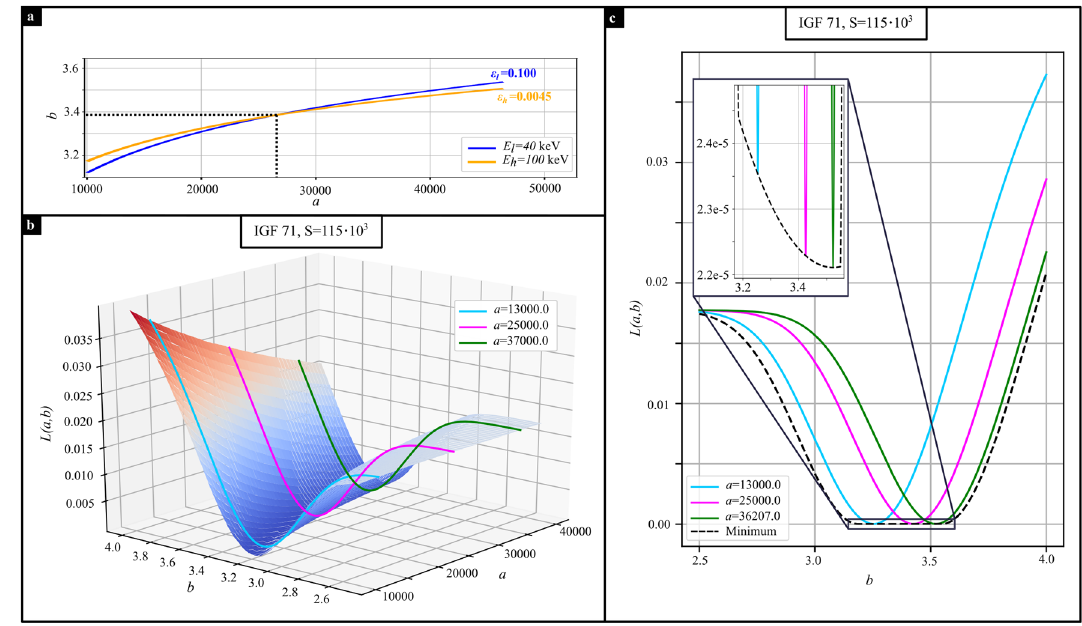
Figure 3. Shape of the optimization landscape. ( a ) Different combinations to achieve ε l and ε h , for different energies E l and E h , with an intersection, marked with black dotted lines. ( b ) Optimization landscape for IGF 71 3 at S = 115 · 10 . ( c ) Line plots through the landscape as indicated in ( b ). The black dotted line provides the minimum of L ( a , b ) depending on b . The zoom-in visualizes the global minimum at b = 3.52 and a = 36207 /